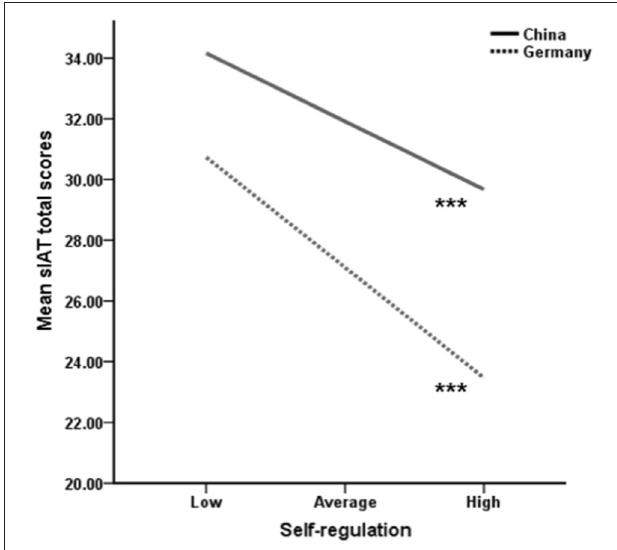
FIGURE 1 | Simple slopes to illustrate the interaction effect between self-regulation and country on s-IAT total scores. Note: *** indicates that the s-IAT change from low to high self-regulation was significant ( p < 0.001).